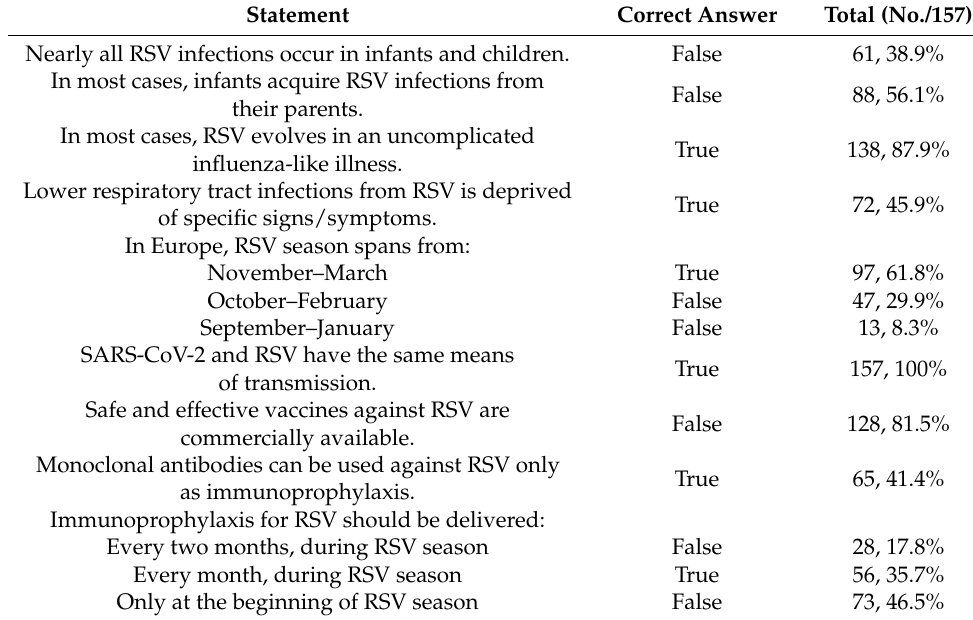
Table 2. Knowledge test showing response distribution of presented items proposed to the 157 medi- cal professionals participating into the survey on respiratory syncytial virus (RSV) and contributing to the assessment of general knowledge score (GKS) (Cronbach’s alpha =